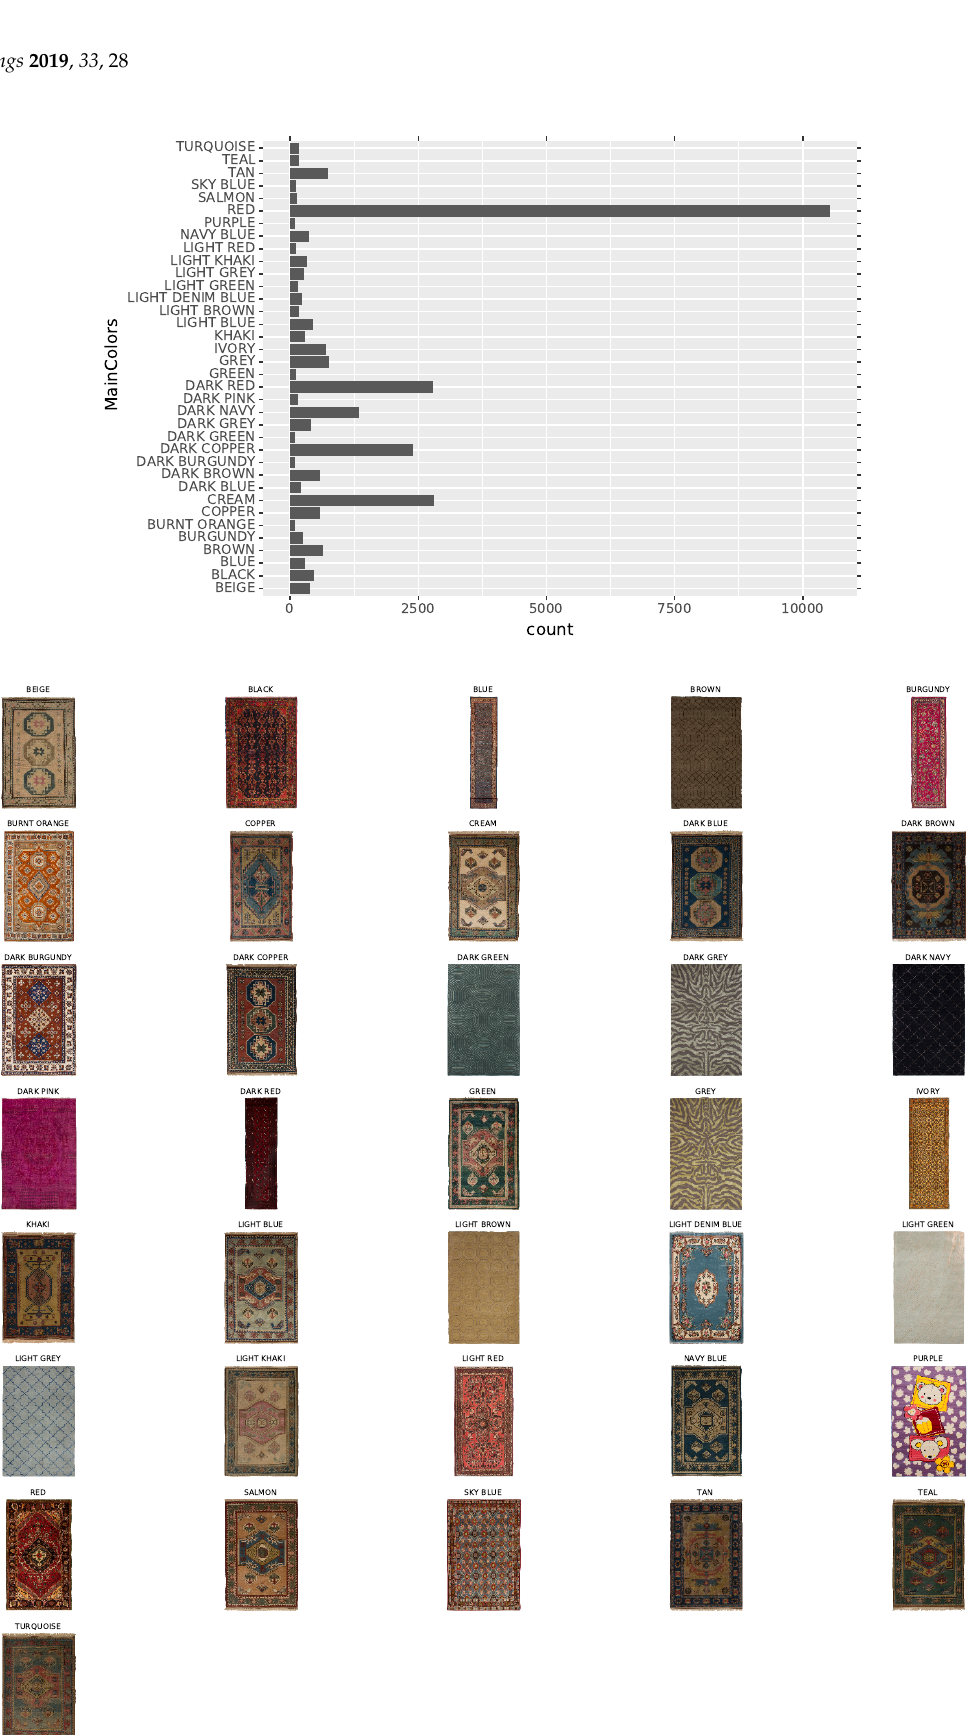
Figure 4. Frequency bar chart and a sample of color level labels. Label names are sorted